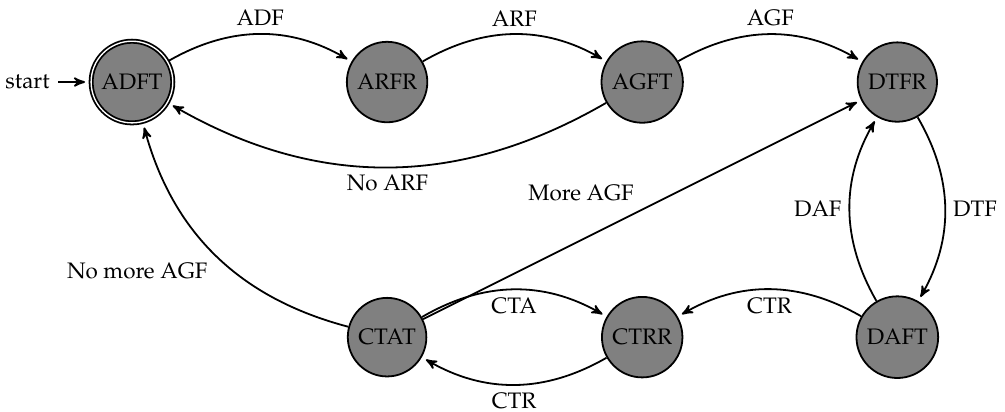
Figure 3. The visible light access point (VLAP) finite state machine in the adaptive polling medium access control (APMAC).